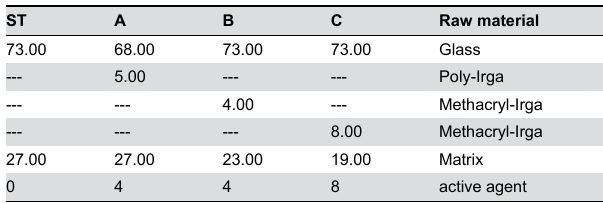
CQ=0.20, amine=0.10, stabilizer=0.10